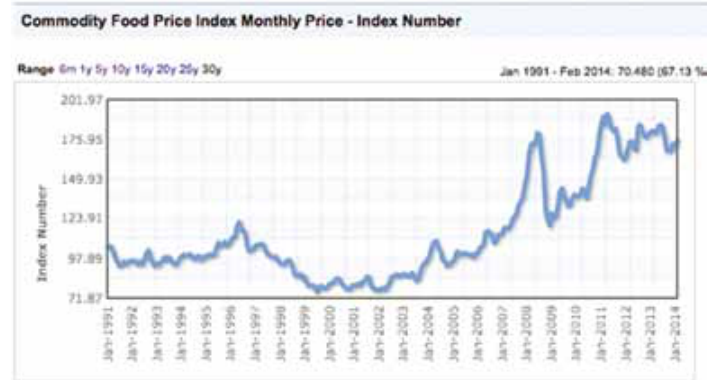
Figure 2: Past trend of world commodity food prices source : FAO,2013